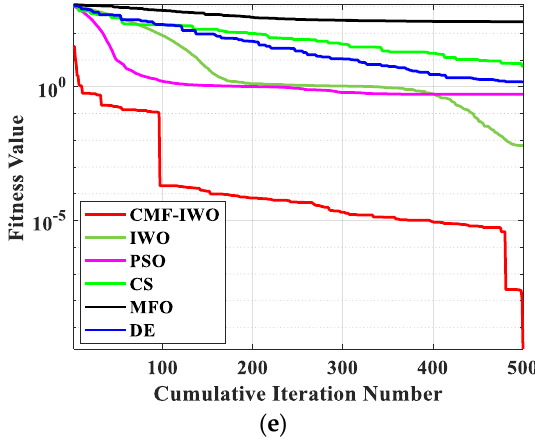
Figure 2. The average iterative curves of benchmark functions: ( a ) F1; ( b ) F2; ( c ) F3; ( d ) F4, and ( e ) F5.